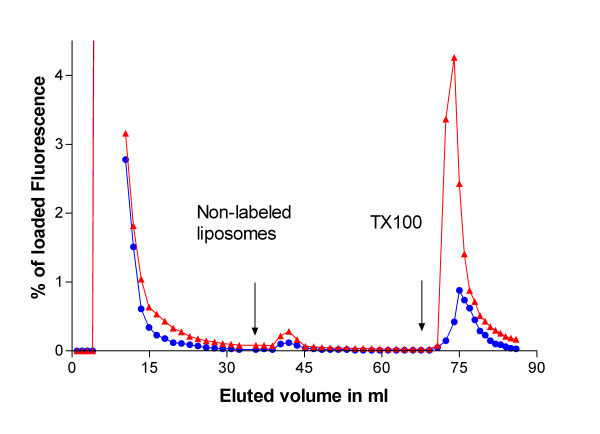
Elution of retained labeled liposomes with Rhod-PE and calcein by passing non-labeled liposomes. Liposomes, labeled with rhod-PE (fluorescence represented with red triangles, ) and containing calcein, 500 μM (fluorescence represented with blue circles, ) were chromatographied on G25M. Fractions of 1.5 mL were collected. The first arrow indicates the injection of unlabeled liposomes on the column and the second arrow indicates the injection of 0.5% TX-100 on the top of the columns.